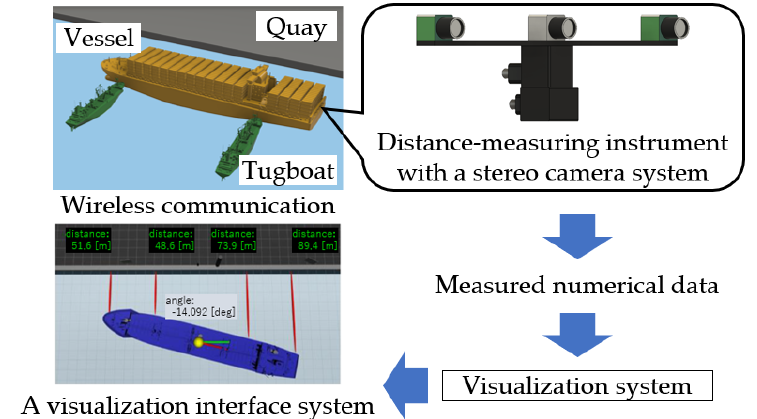
Figure 2. Schematic of the portable interface